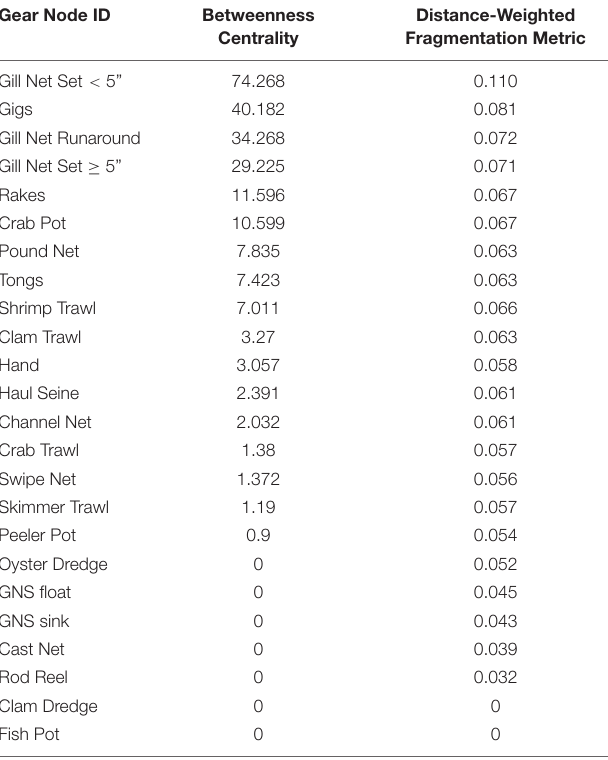
TABLE 4 | Betweenness Centrality and Distance-weighted Fragmentation Metric F calculated in Key Player for the nodes in the reduced Fisher Behavioral Network. Gear Node ID